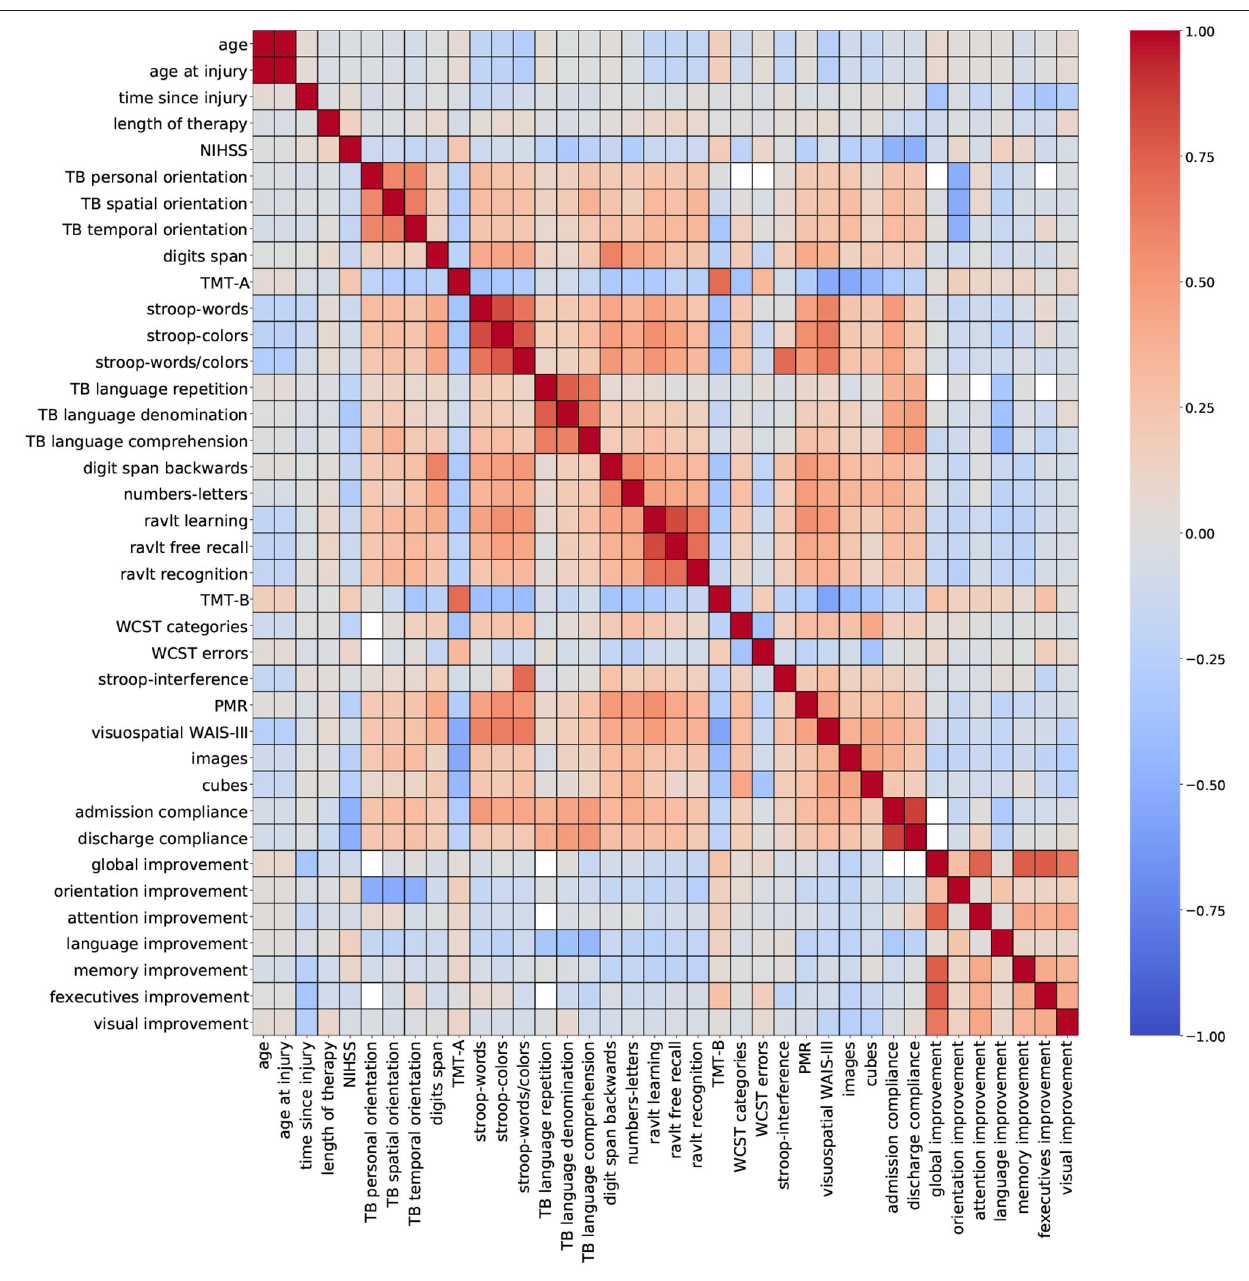
were pre-selected to be considered for